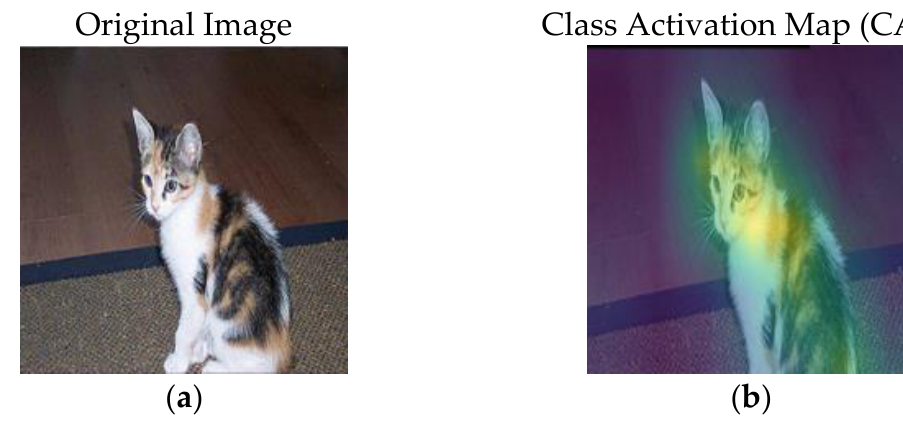
Figure 8. ( a ) Input image; ( b ) output of class activation map (CAM). Figure 9 shows the results of various pre-trained models, such as VGG 16, VGG 19, ResNet 101, and ResNet 152 with the corresponding results of Grad-CAM, Grad-CAM++, bounding box prediction, and proposed method (GradCAM-MLRCNN) that contains the bounding box with mask prediction concerning the decision tree : (a) various pre-trained models; (b) results of Grad-CAM; (c) results of Grad-CAM++; (d) bounding box prediction on Grad-CAM++; and (e) GradCAM-MLRCNN. Figure 10 shows the original image and its corresponding class activation map